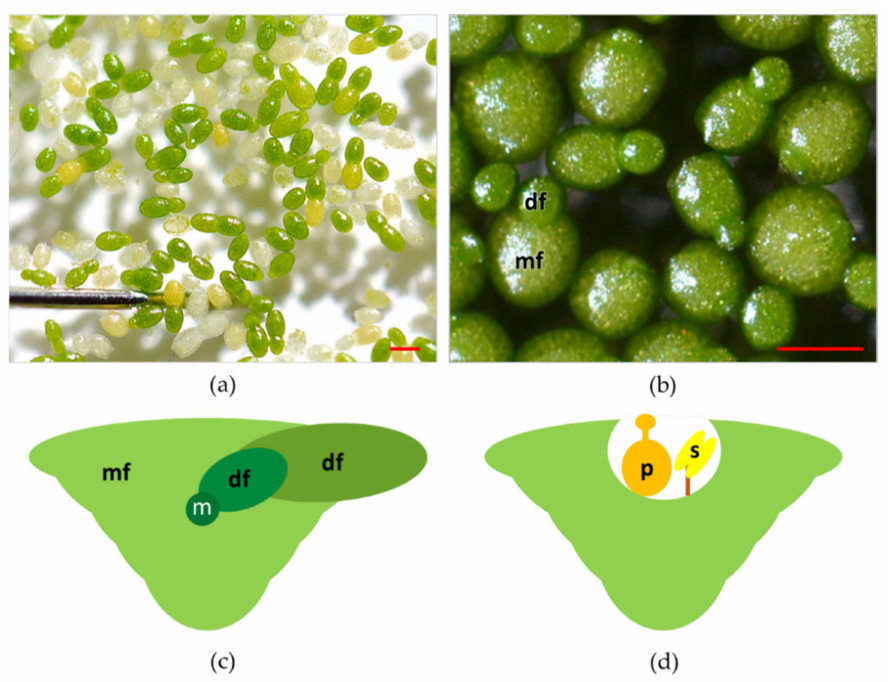
Figure 2. ( a ) Top view of plants of Wolffia arrhiza also showing a stainless-steel pin for size compari- son; ( b ) close view of plants of Wolffia arrhiza. Some individual plants feature both the mother frond (mf) and the daughter frond (df); ( c ) schematic transversal section of a plant of Wolffia sp. vegetatively reproducing, mother frond (mf), meristem (m), daughter frond (df); ( d ) schematic transversal section of a plant of Wolffia sp. in full bloom, pistil(p), stamen (s). Red bars = 1